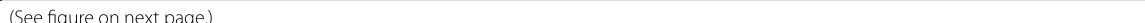
(See figure on next Fig. 15 Begonia zhuoyuniae C.I Peng, Yan Liu & K.F.Chung. A – C , F Habit and habitat; D Rhizome and leaf adaxial surfaces; E Leaf abaxial surfaces; G Inflorescence, showing indumentum on tepals and pedicels; H Developing fruit; I Stipule; J Staminate flower bud and bracteoles; K , L Staminate flower; M , N Pistillate flower; O Cross section of ovary. A , B , H from C.‑I Peng 21061 ; C , F , K field photos taken by Yan Liu without voucher; D , E , I , J , L – O from C. ‑ I Peng 20737 ‑ A (HAST); G from S. ‑ M. Ku 2024